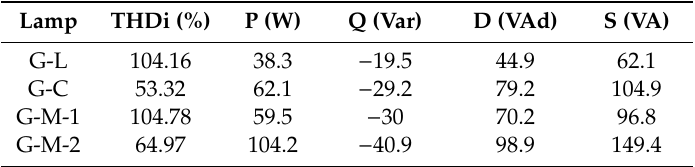
Figure 3. Measurements obtained for the G-M-2 grouping: Harmonic spectrum ( a ), waveform ( b ) and phasor diagram ( c ). Table 7. Values measured with the Fluke parsed in the four groups.